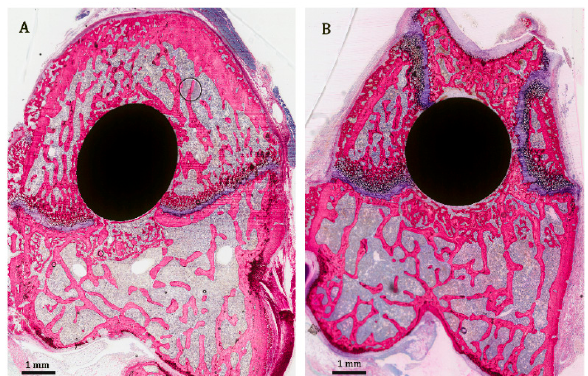
Figure 5. Representative histological images stained with methylene blue and basic fuchsin, showing non-decalcified (pMMA embedded) cross-sections displaying the varying amount of tight bone contact to implant in different treatment groups. ( A ) osteoporotic condition, alendronate group. ( B ) healthy condition, combination group.